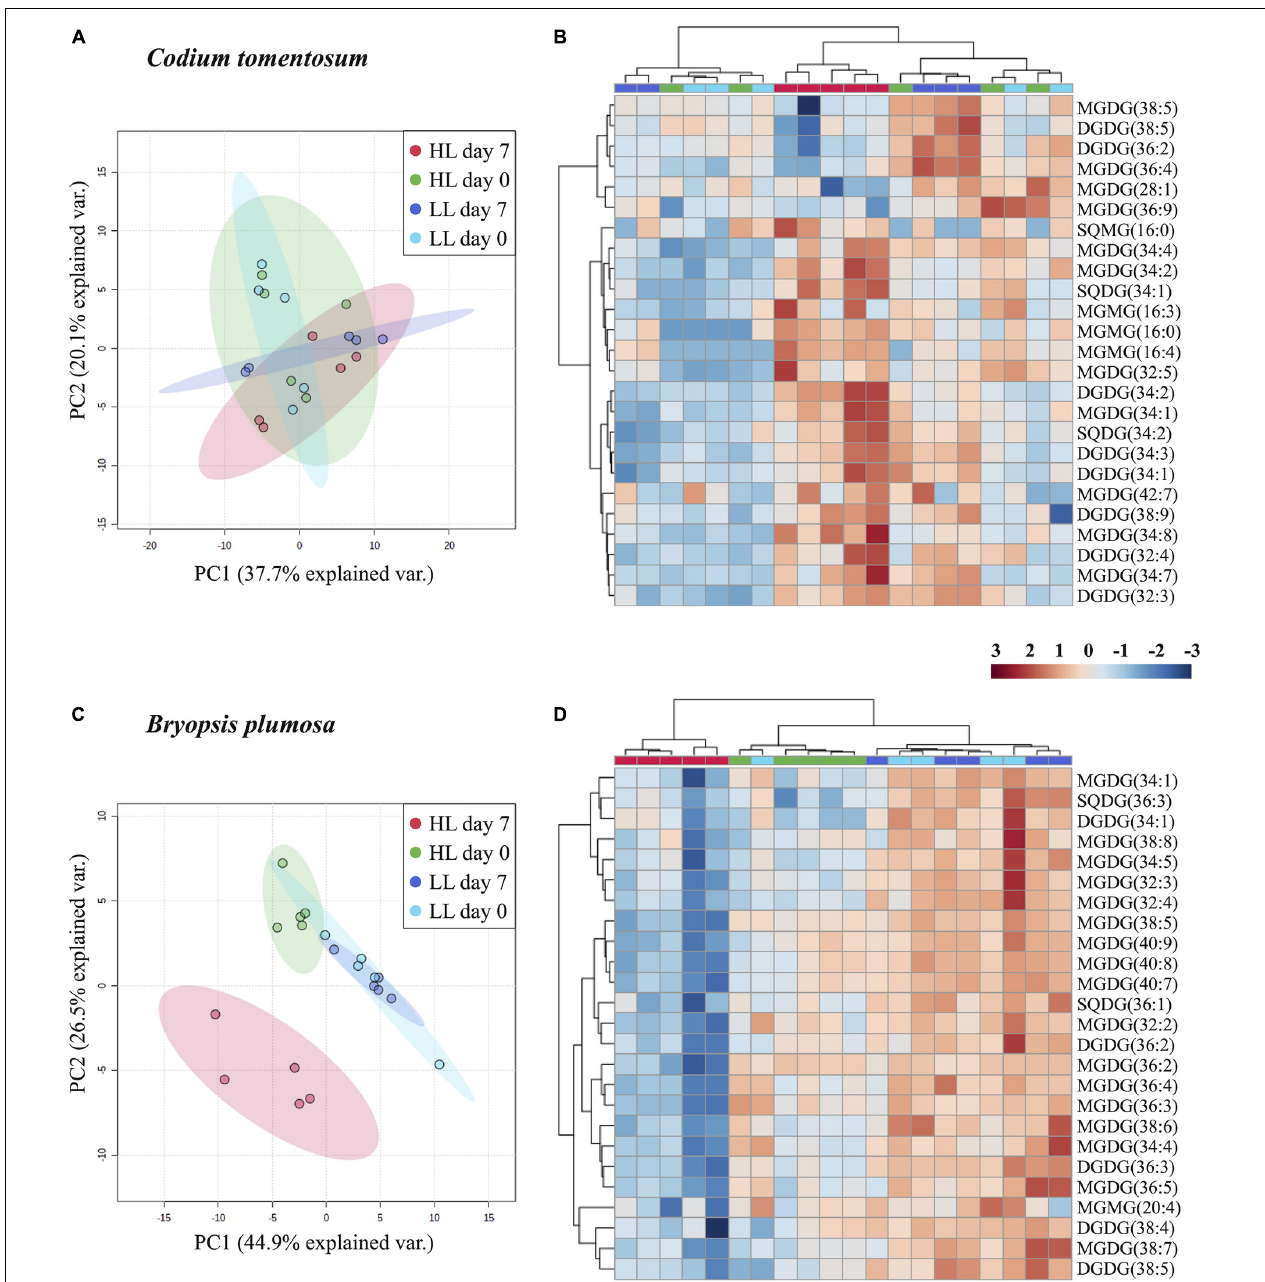
FIGURE 6 | Principal component analysis (PCA) and heatmap/clustering analysis of glycolipids profile discriminating macroalgae at low light (LL) and high light (HL) at the beginning (day 0) and at the end (day 7) of the light acclimation. (A) PCA 2D score plot— Codium tomentosum ; (B) heatmap/clustering— C. tomentosum ; (C) PCA 2D score plot— Bryopsis plumosa (D) heatmap/clustering— B. plumosa . PCA scores plot were performed using the complete glycolipid dataset (normalized XIC areas) while for heatmaps/clustering analysis the 25 molecular species that most contributed to differentiation between treatments were selected (PLS-DA